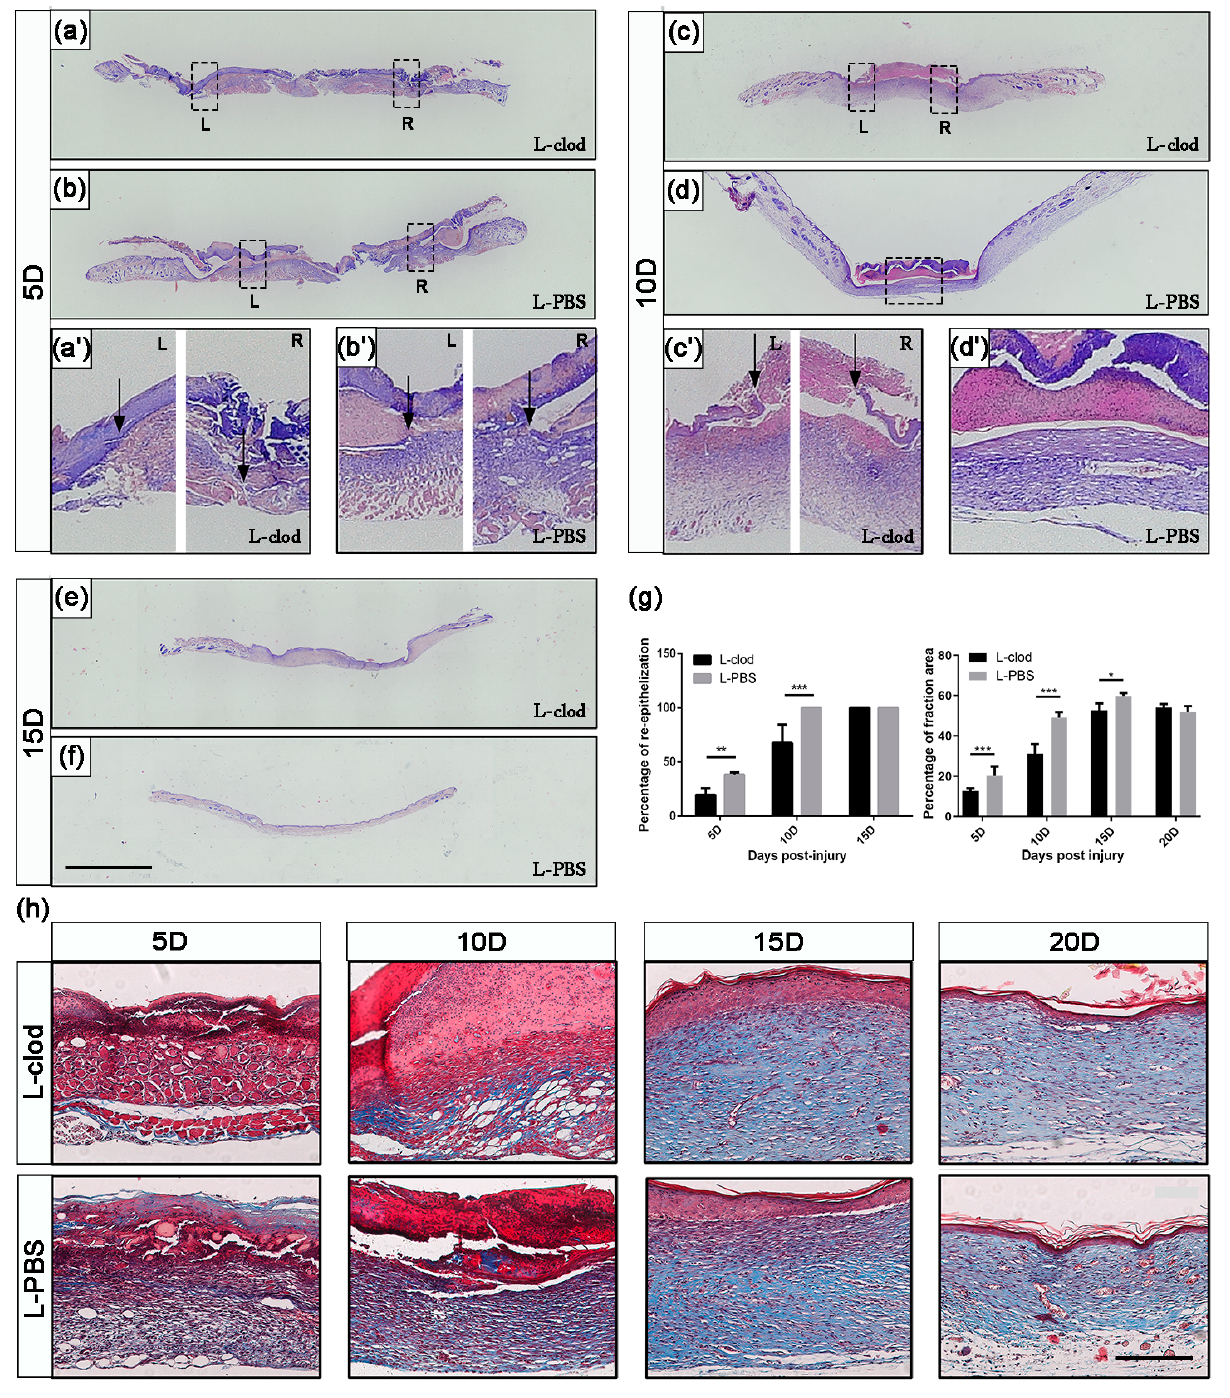
Figure 3. Analysis of re-epithelialization and collagen deposition after macrophage depletion. Tissues of wound sites from L-clod- and L-PBS-injected mice were collected at 5D, 10D, and 15D and stained with H&E ( a – f , scale bar: 2.5 mm). Dashed boxes mark inset showing high-magnifica- tion images ( a’ – d’ ). Black arrows indicate ends of migrating epithelial tongues. The statistics of